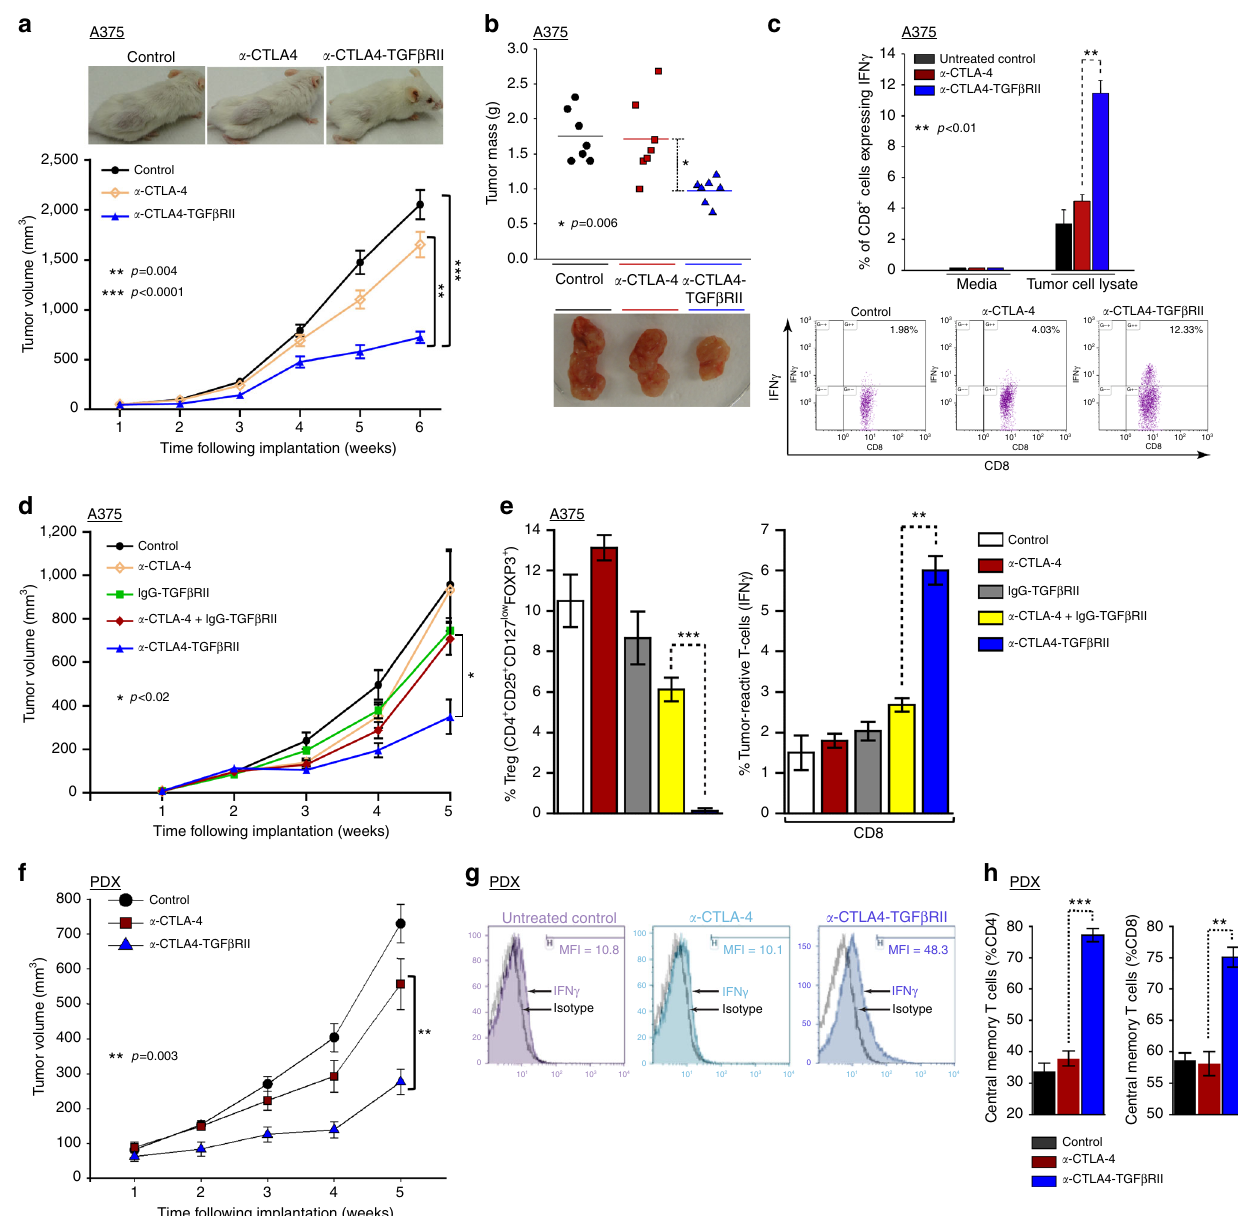
Fig. 4 a -CTLA4-TGF β RII exhibits superior antitumor ef fi cacy with elevation tumor-reactive IFN γ -expressing and central memory T cells. Effect of the indicated treatments on melanoma tumor xenografts in NSG mice that were immune reconstituted with tumor-matched HLA A2 + human CD34 + BM cells. Mice engrafted with human CD3 + cells were inoculated subcutaneously with either human melanoma tumor cells (A375) or patient-derived melanoma tumor xenografts. At 10d following tumor inoculation, mice were randomized into groups and treated with the indicated antibodies (5 mg kg − 1 i.p. weekly) or vehicle alone (untreated control). a Representative images and in vivo tumor growth curves in A375 tumor-bearing mice: (mean + SEM of 12 mice in each indicated group). b Representative images and mass of tumors at the end of treatment in A375 tumor-bearing mice: (seven mice in each indicated group). c Flow cytometric analysis of the comparative in vivo effect of the indicated treatments on tumor-reactive IFN- γ expression in CD8 + T cells in A375 tumor-bearing mice. Representative fl ow data is shown (mean ± SEM). d , e Comparative antitumor ef fi cacy of a -CTLA4-TGF β RII, a -CTLA-4, nonspeci fi c